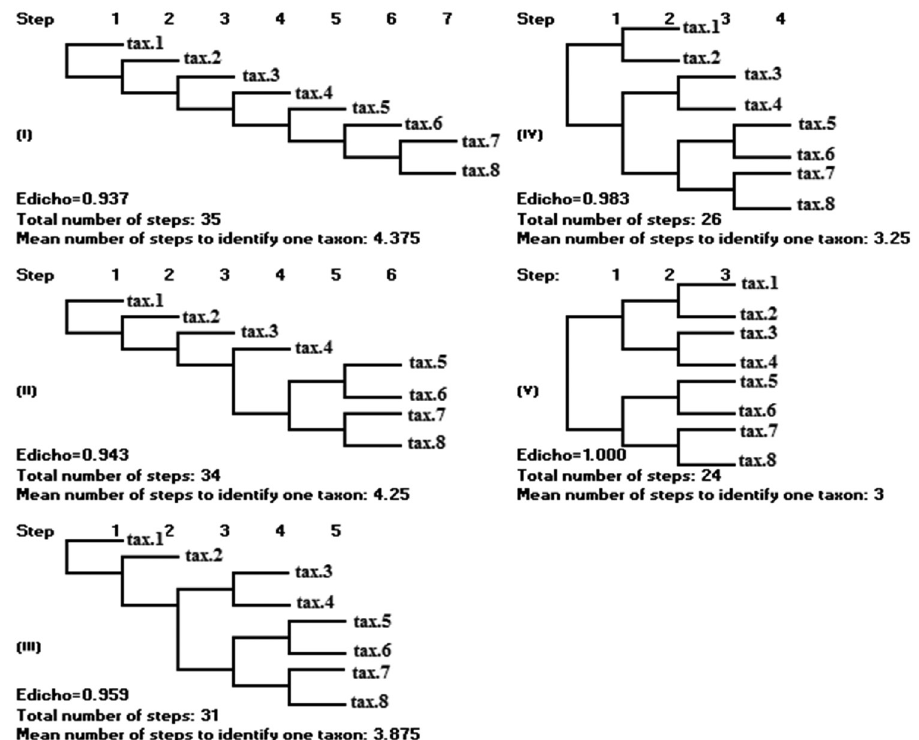
Figure 1. Schematic presentation of 5 dichotomous keys for a group of 8